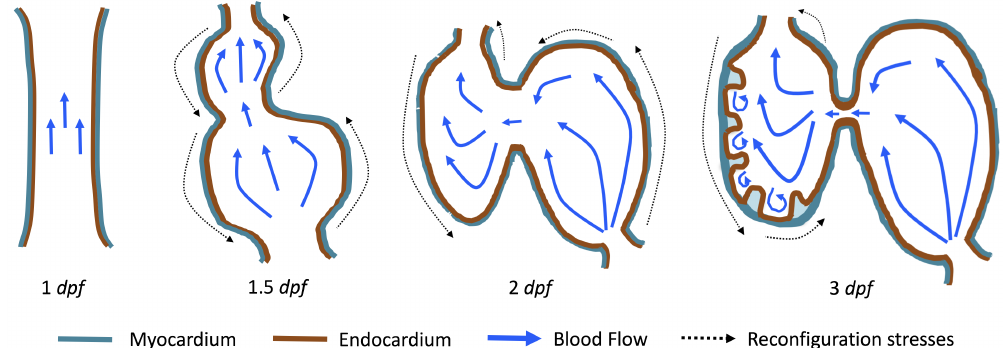
Figure 1. Illustrations of significant stages of zebrafish heart development. At 1 dpf the heart begins pumping as a valveless heart tube, at 1.5 dpf cardiac looping and chamber ballooning begins, at 2 dpf the heart is a growing two-chambered pumping system with endocardial cushions forming, and at 3 dpf ventricular trabeculation occurs. The blue arrows indicate blood flow while the black dotted arrows represent mechanical stresses re-configuring the